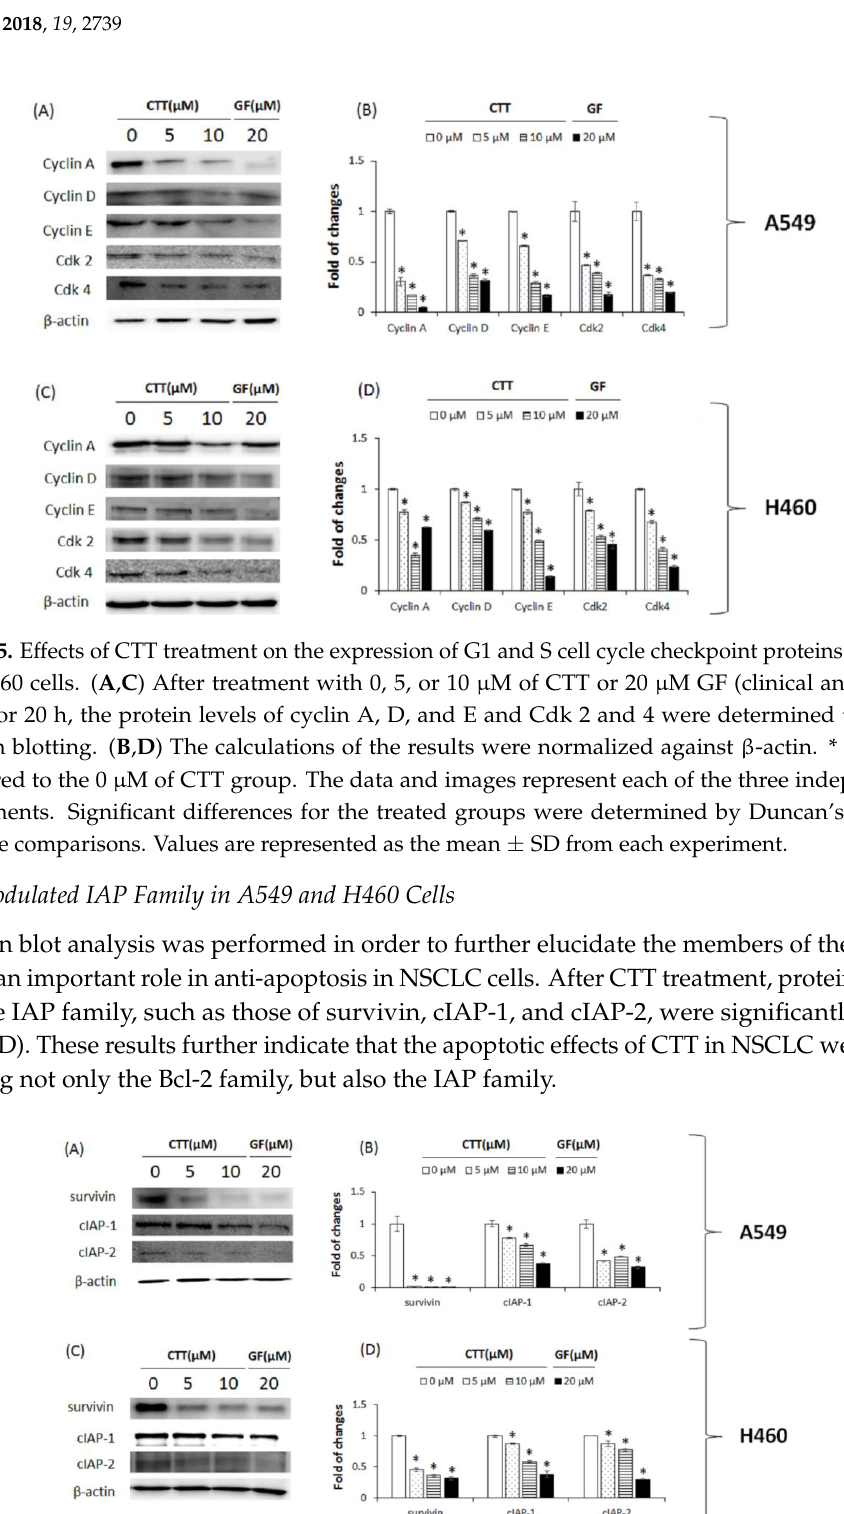
Figure 6. Effects of CTT treatment on the expression of IAP family proteins in A549 and H460 cells. ( A , C ) After treatment with 0, 5, or 10 μM of CTT or 20 μM GF (clinical anticancer drug) for 20 h, the protein levels of cIAP-1, cIAP-2, and survivin were determined through western blotting. ( B , D ) The calculations of the results were normalized against β-actin. * p < 0.05 compared to the 0 μM of CTT group. The data and images represent each of the three independent experiments. Significant differences for the treated groups were determined by Duncan’s test for multiple comparisons. Values are represented as the mean ± SD from each experiment.